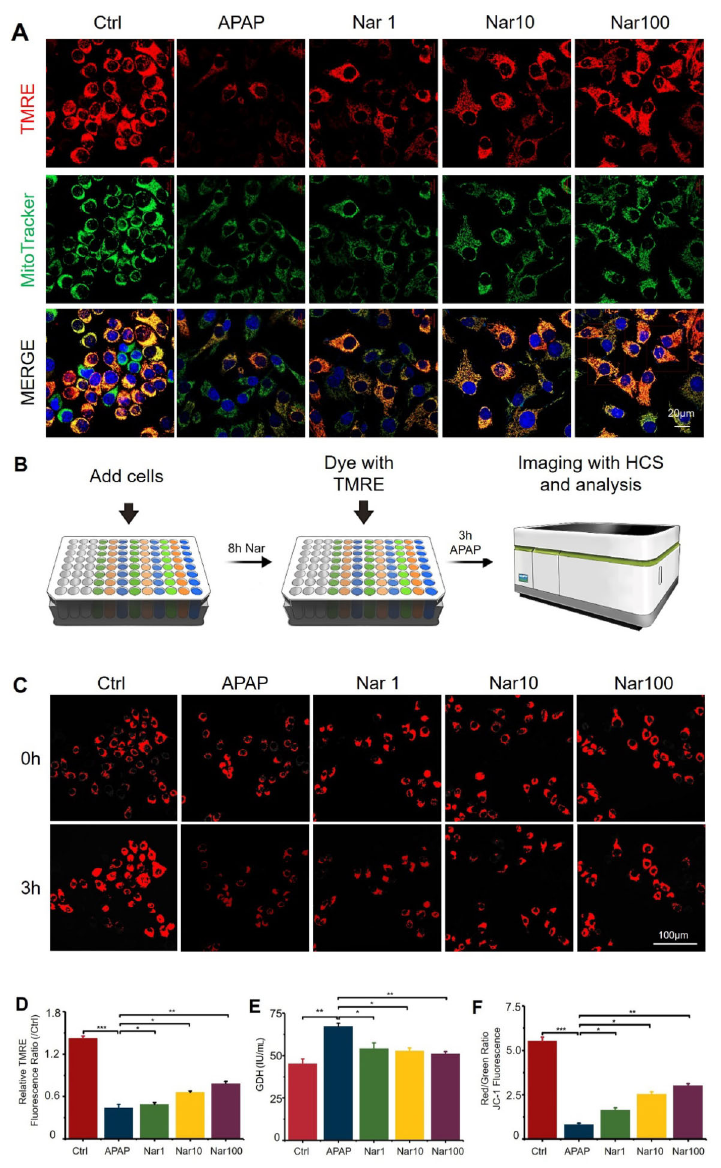
Figure 4. Naringin (Nar) prevented acetaminophen (APAP)-induced mitochondrial injury in HepG2 cells. A , Detection of changes in the TMRE/MitoTracker Green fl uorescence signal by confocal microscopy (scale bar 20 m m). B , Flow chart of high-content analysis monitoring of MMP changes. C and D , TMRE intensity indicating the MMP at 0 and 3 h in different groups (scale bar 100 m m). E , Changes in the glutamate dehydrogenase (GDH) level, an index of mitochondrial injury, in different groups after 24 h APAP-induced injury. F , Red/green fl uorescence ratio in JC-1-stained cells. Data are reported as means ± SD (n=3). *P o 0.05, **P o 0.01, and ***P o 0.001 vs the APAP group ratio of p-Drp1 (Ser616) to total Drp1 (Figure 5B and C). Taken together, these results showed that APAP induced mitochondrial fragmentation via downregulation of mito- chondrial fusion proteins. Nar promoted mitochondrial fusion, thus ameliorating mitochondrial malfunction under APAP-induced oxidative stress.